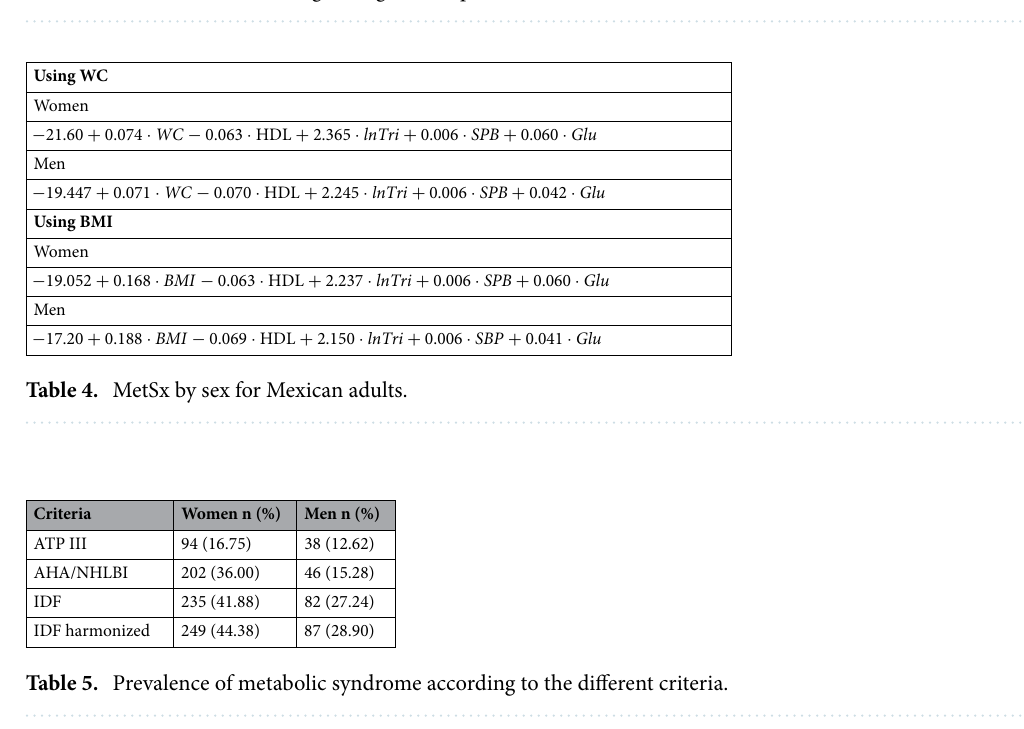
Table 3. Confirmatory factor analysis estimation with transformed and standardized variables. The letter N in HDL indicates that the negative of HDL was used, and the letter Z indicates that the variable was standardized. SFW: Standardized factorial weights. Significant p-values are in bold.